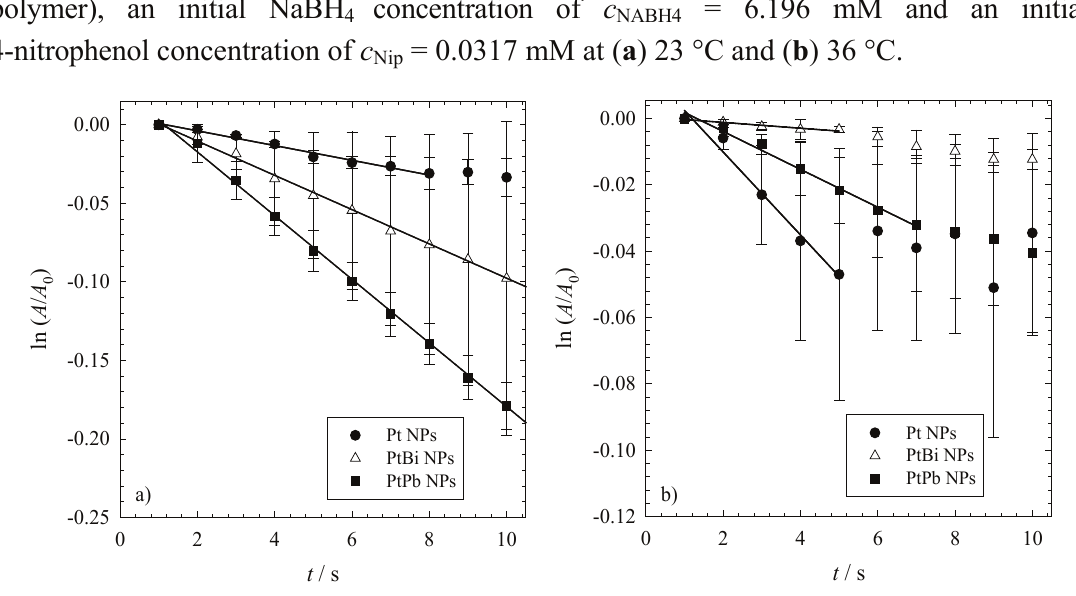
Figure 3. The time-dependent change of the concentration of 4-nitrophenol ln( A / A ) versus 0 time t . All reductions were performed with 1mg of catalyst ( i.e. , 0.3 mg NPs and 0.7 mg polymer), an initial NaBH concentration of c = 6.196 mM and an 4 NABH4